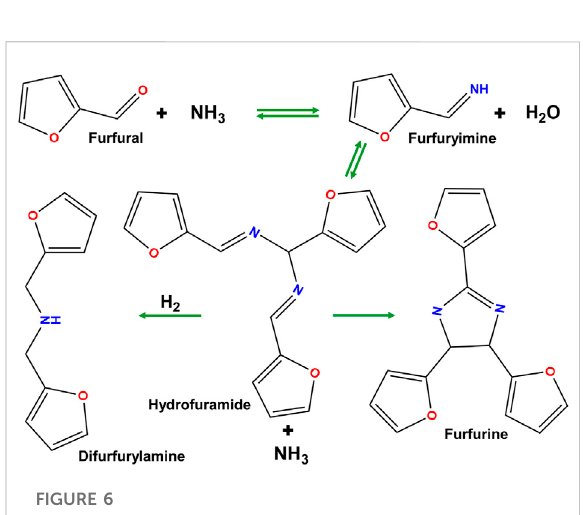
FIGURE 6 Chemicals formed during ammonia exposure to furfural adapted from (Mariscal et al.,